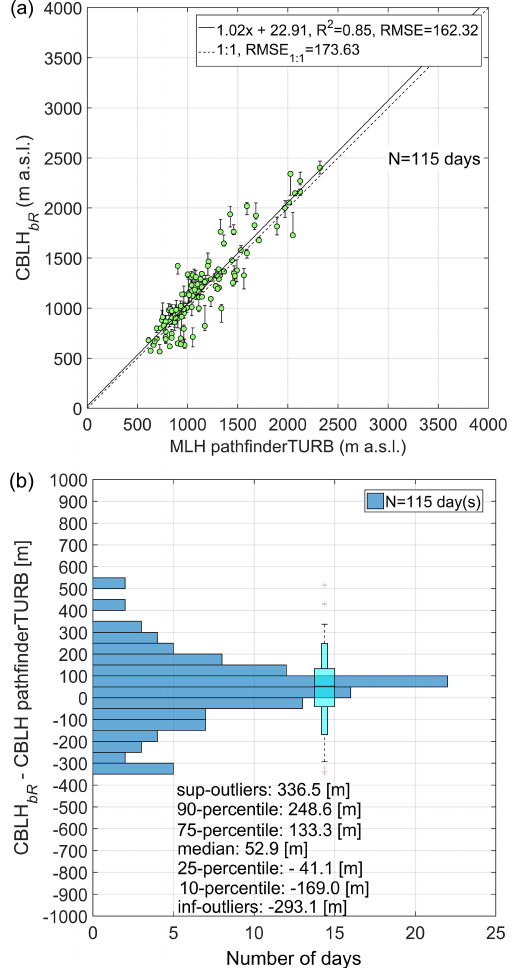
Figure 4. All data shown refer to 12:00UTC. (a) Scatter plot of CBLH bR versus CBLH PathfinderTURB . (b) Box plot and histogram of the difference between the bR and PathfinderTURB datasets.